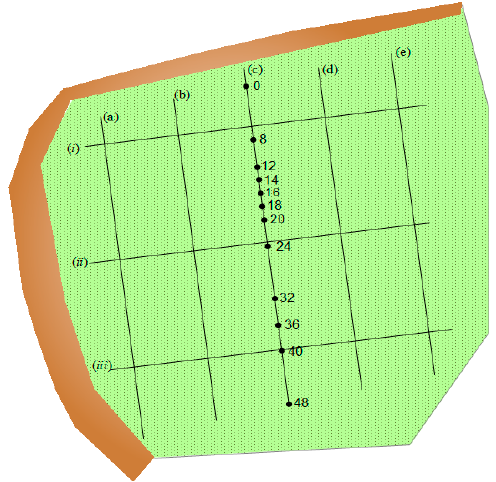
Figure 1. Measurement axes and probe distances.